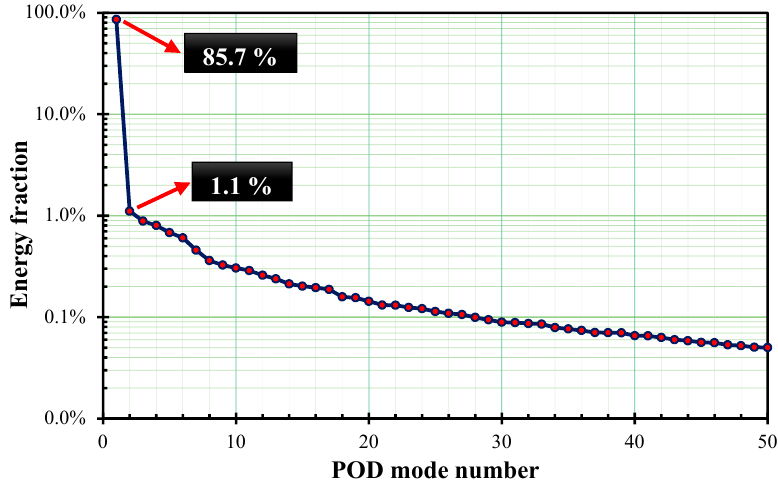
Figure 18. The energy fraction captured by the first 50 phase invariant POD modes at valve lift 9 mm.